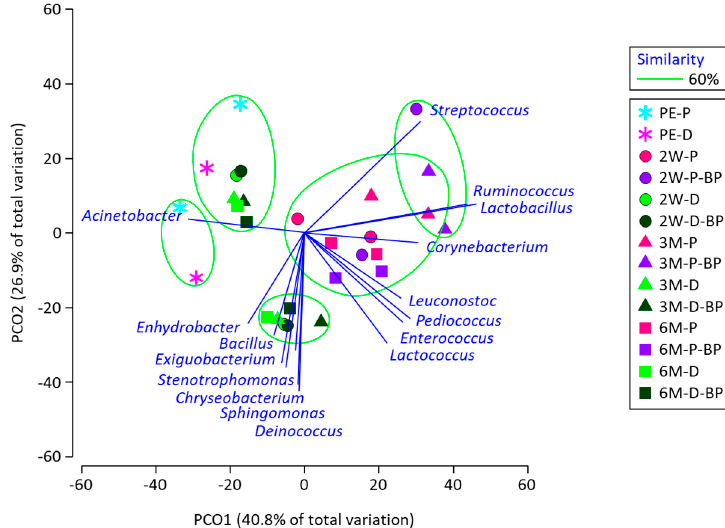
Figure 2. Principal coordinates plot characterizing bacterial microbiota of soybean curd residue silage prepared with prompt and delayed sealing and with and without beet pulp addition. The operational taxonomy unit with a Pearson’s correlation of > 0.7 is overlaid on the plot as vectors. Samples enclosed in the same group at a 60% similarity level are denoted with green circles. PE, 2W, 3M, and 6M indicate pre-ensiled material and silage stored for 2 weeks, 3 months, and 6 months, respectively. P, D, and BP after the hyphenation denote prompt sealing, delayed sealing, and beet pulp addition, respectively.